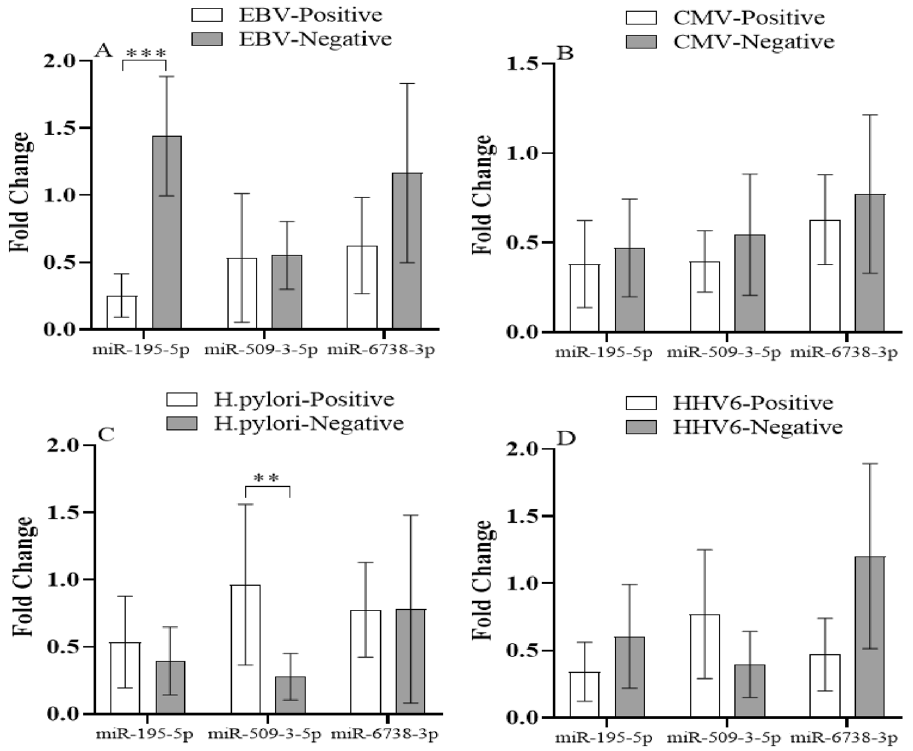
Figure 7. Expression level of Shh signaling pathway regulatory miRNAs in non-tumoral and tumoral gastric cancer tissues according to viral infections. ** and *** indicates significant difference P < 0.01 and 0.001, respectively. EBV; Epstein-Barr virus, CMV; Cytomegalovirus, HHV6; Human herpesvirus